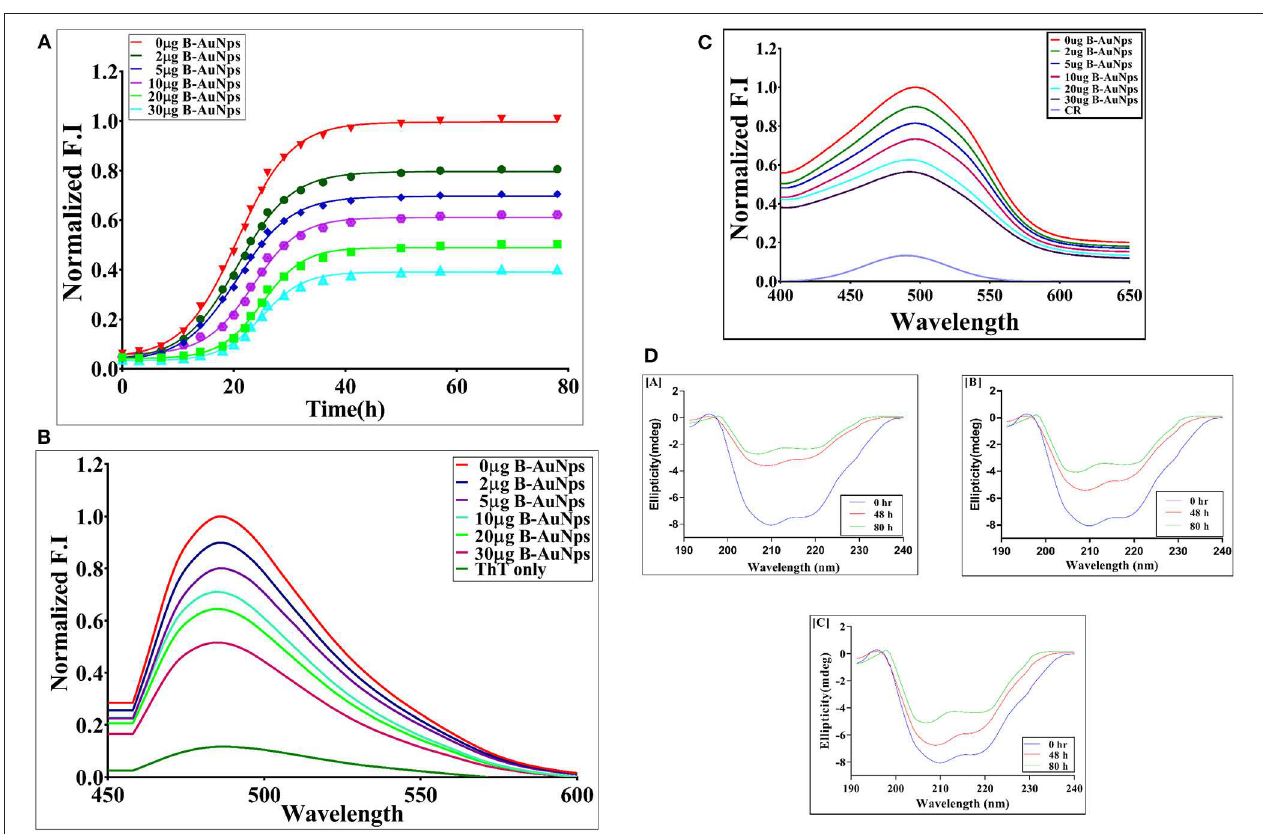
FIGURE 3 | (A) Time kinetics of OVA aggregation in the presence of B-AuNPs: The effect of B-AuNPs on synthesis of OVA amyloid was monitored by determining ThT fluorescence associated with as-formed OVA amyloid. The OVA amyloid synthesis followed a sigmoidal kinetics that involves around 5h lag phase before attainment of exponential phase. The presence of B-AuNPs resulted in inhibition of OVA-amyloid synthesis in concentration dependent manner. (B) ThT fluorescence spectra of as-synthesized OVA fibril generated in the presence of increasing concentration of B-AuNPs: Absorption fluorescence spectra of ThT bound mature OVA amyloid species generated at a given time point. The effect of presence of B-AuNPs on generation of OVA amyloid was monitored by plotting absorption fluorescence spectrum of mature OVA amyloid formed. The B-AuNPs inhibited OVA amyloid synthesis in dose dependent manner. (C) CR absorption spectra of as-synthesized OVA in the presence of increasing concentrations of B-AuNPs: The amyloid synthesis of OVA was induced in the presence of increasing concentration of B-AuNPs at 25 ◦ C for a definite time periods (24h). CR solution (20 µ M) in PB served as a control (CR-only spectrum). B-AuNPs were found to reinstate red shift in as formed OVA-fibril. Experimental data represent of means of three determinants ± S.D ( n = 3). The data is representative of three different experiments with same pattern. (D) Far UV CD spectra of as-synthesized OVA fibril synthesized in the presence of increasing concentrations of B-AuNPs: The CD spectrum of native OVA showed characteristic α -helical structure with negative MRE peaks at 210 and 218nm. CD spectra of OVA shaken for various time points (in the absence of B-AuNPs) showed transformation of α -helical structure to β -sheet with the increase in incubation time. The fibril formation was accompanied with alpha helix to beta sheet structural transition in the OVA protein (negative peak at 218nm). A decrease in the β content was seen when OVA fibril formation was induced in the presence of B-AuNPs. The as-synthesized B-AuNPs inhibited OVA fibril formation in concentration dependent manner [A] 0 µ g B-AuNPs; [B] 2 µ g B-AuNPs; [C] 30 µ g